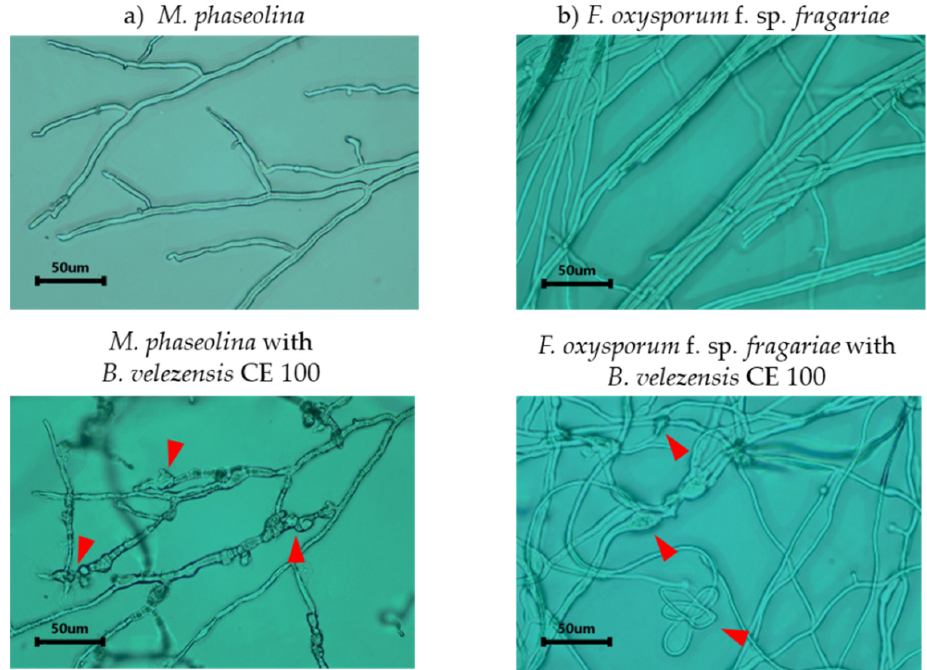
Figure 4. Inhibition effect of Bacillus velezensis CE 100 on phytopathogenic hyphal morphologies of Macrophomina phaseolina ( a ) and Fusarium oxysporum f. sp. fragariae ( b ), observed via light microscopy. On the top, the normal morphology in the control groups, and at the bottom, the corresponding effect of B. velezensis CE 100. Arrows indicate hyphal alterations with swelling and deformation of structures caused by B. velezensis CE 100.